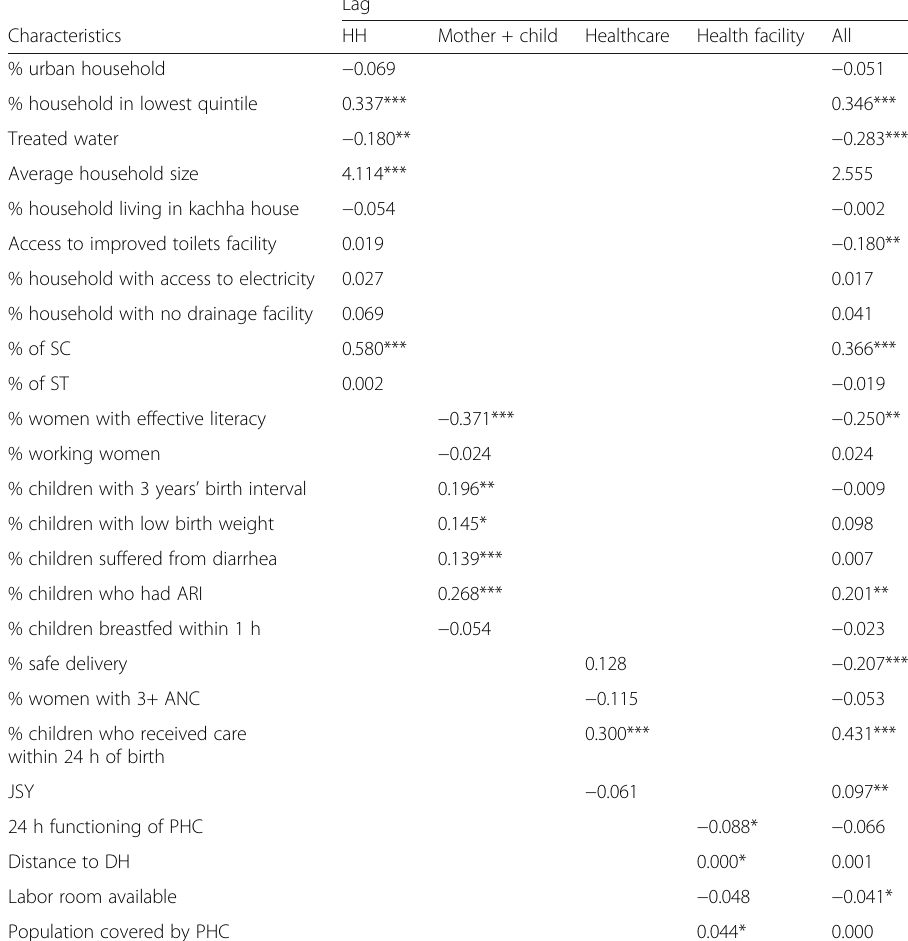
Table 3 Result of Spatial Lag model assessing determinants of IMR, High Focus States, 2010 –